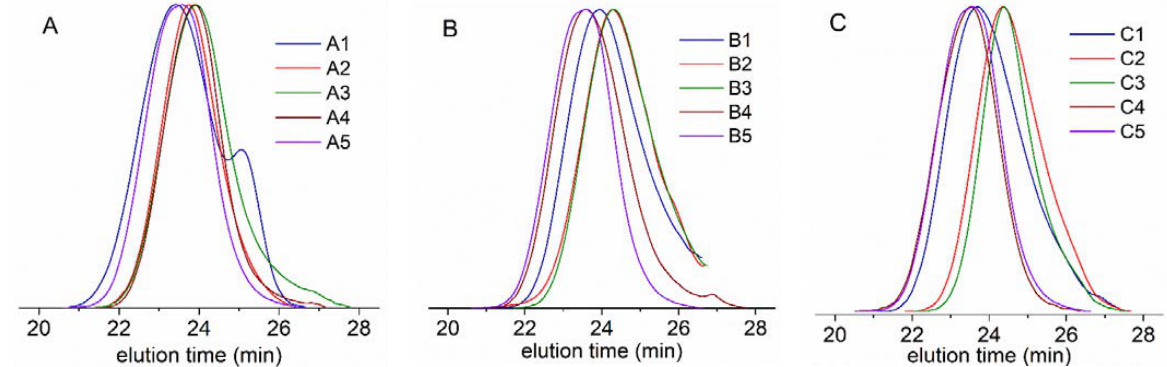
Figure 5. GPC analysis of polyesters of Series I ( A ), Series II ( B ) and Series III ( C ).